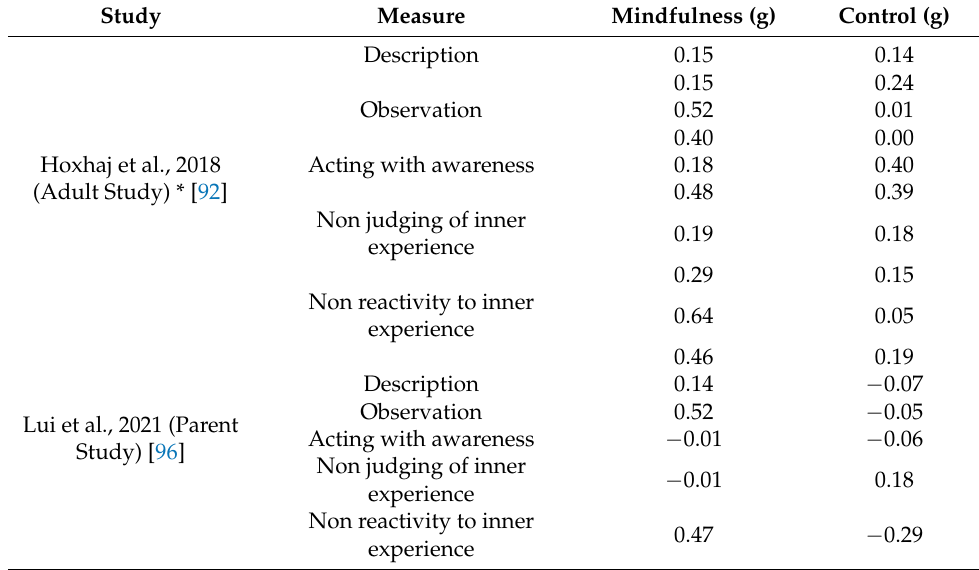
Table 10. Effect sizes for the Five Facet Mindfulness Questionnaire which was used in two